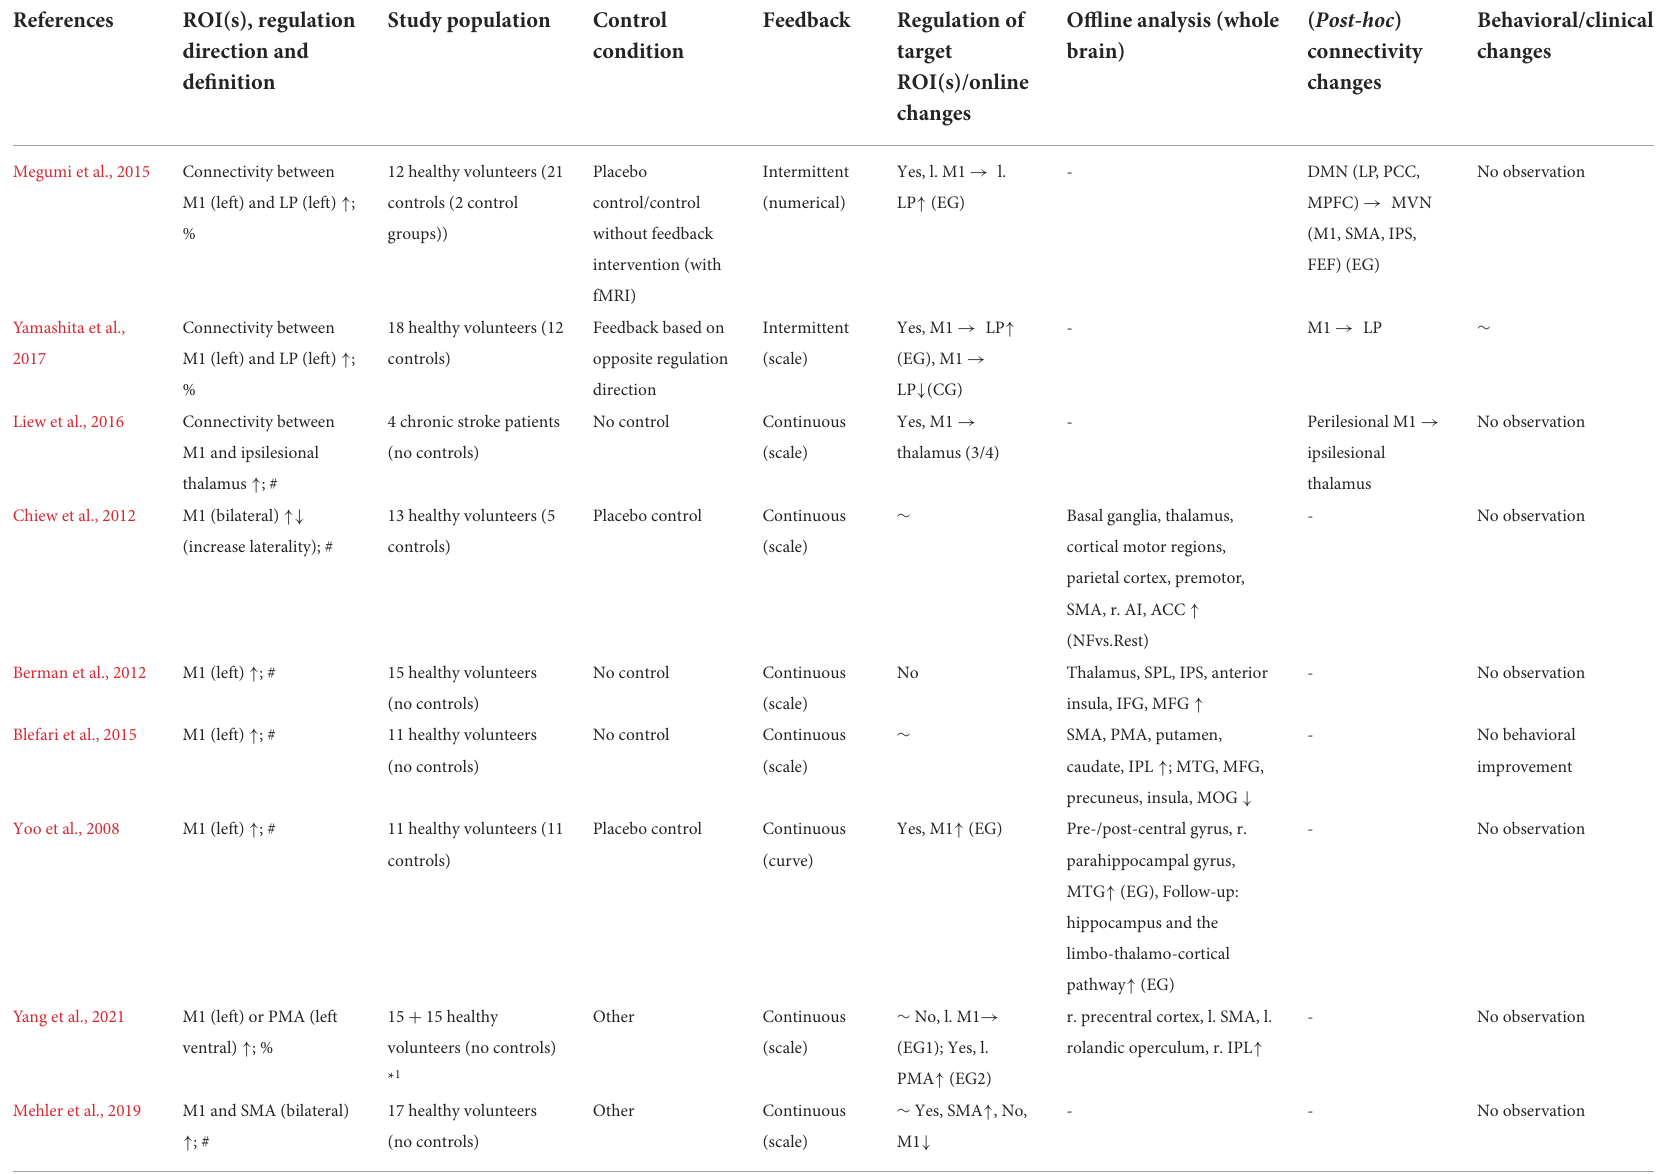
TABLE 3 Details of real-time fMRI neurofeedback studies with regulation target in the “motor